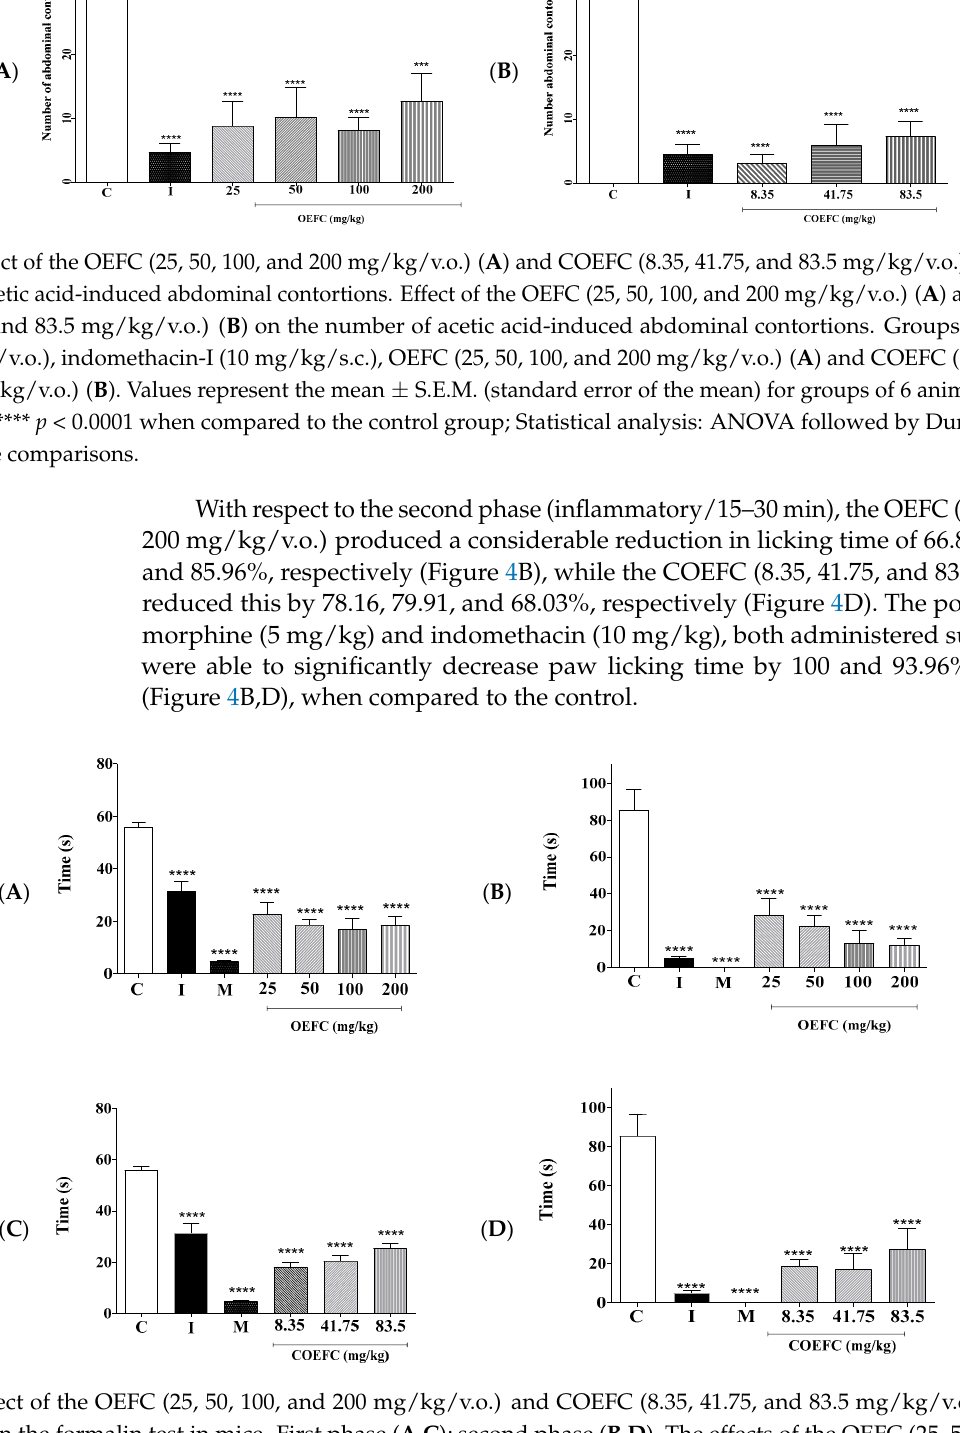
Figure 4. Effect of the OEFC (25, 50, 100, and 200 mg/kg/v.o.) and COEFC (8.35, 41.75, and 83.5 mg/kg/v.o.) on paw licking time in the formalin test in mice. First phase ( A , C ); second phase ( B , D ). The effects of the OEFC (25, 50, 100, and 200 mg/kg/v.o.) and COEFC (8.35, 41.75, and 83.5 mg/kg/v.o.) on paw licking time in the formalin test in mice are outlined below. First phase ( A , C ); second phase ( B , D ). Groups: control-C (0.1 mL/10 g/v.o.), indomethacin-I (10 mg/kg/s.c.), morphine-M (5 mg/kg/s.c.), OEFC (25, 50, 100, and 200 mg/kg/v.o.) ( A , B ), and COEFC (8.35, 41.75, and 83.5 mg/kg/v.o.) (C/D). Values represent the mean ± S.E.M. (standard error of the mean) for groups of 6 animals, where **** p < 0.0001 when compared to the control group; Statistical analysis: ANOVA followed by Dunnett’s Test with multiple comparisons.